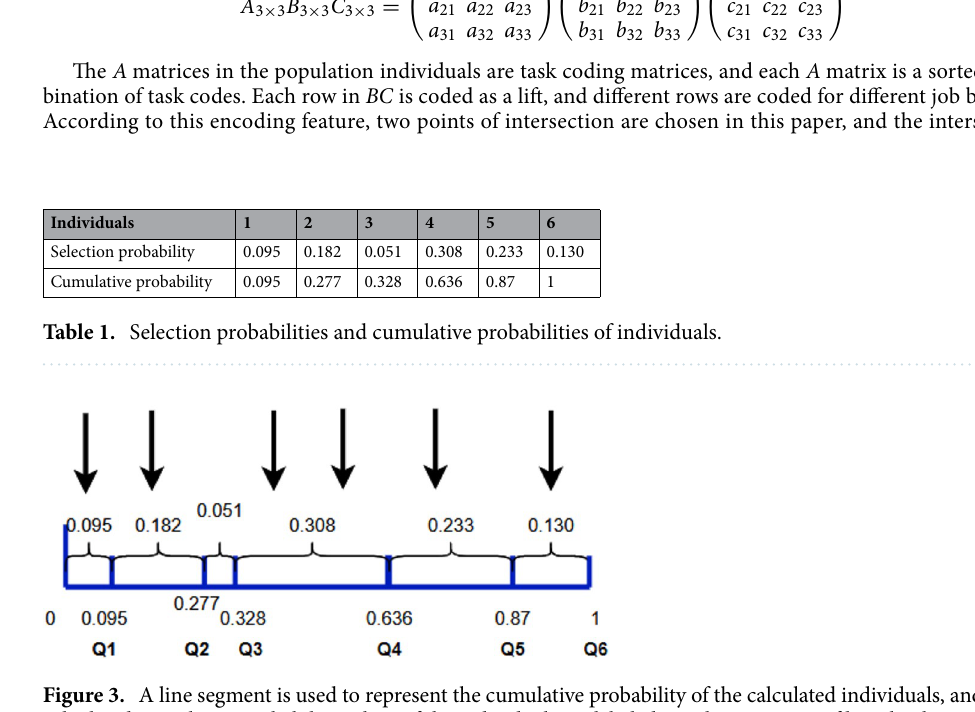
Figure 3. A line segment is used to represent the cumulative probability of the calculated individuals, and the calculated cumulative probability values of the individuals are labeled on a line segment of length 1 by setting a 0 point at the start point of the left end. Six numbers were randomly generated on the interval (0,1), and as seen in the figure, the selected individuals were 1, 2, 4, 4, 5, and 6. Individual number 4 was selected